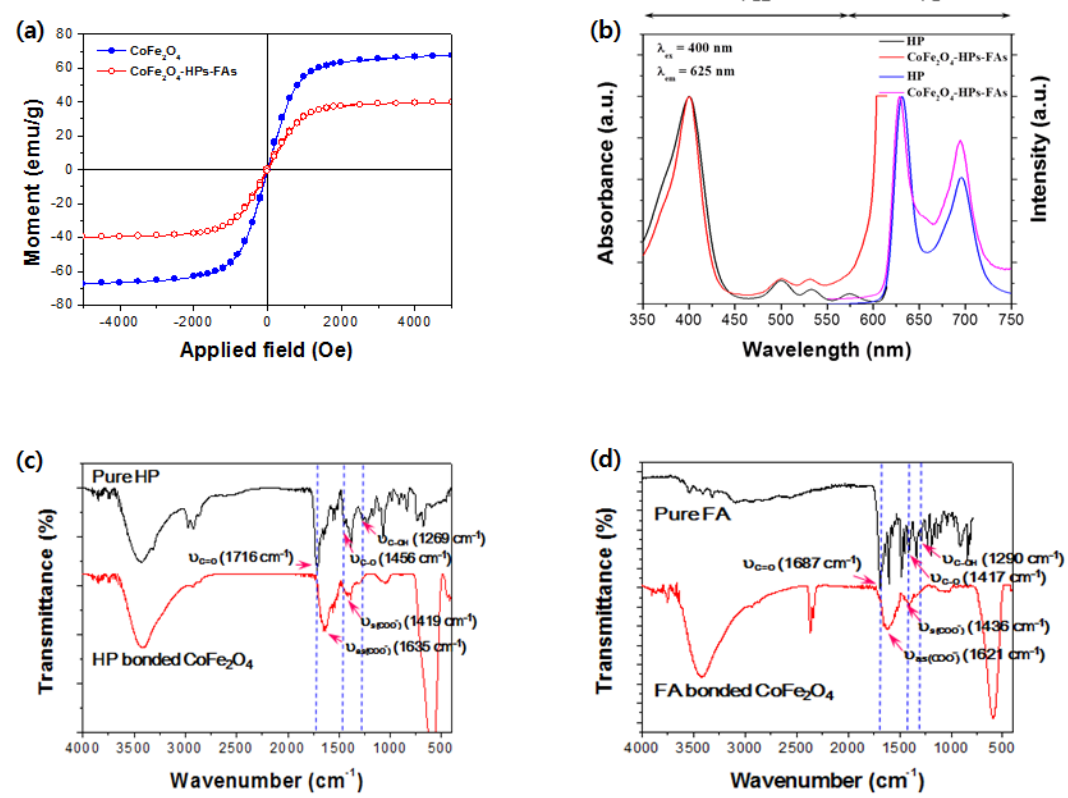
Figure 2. Photophysical and magnetic properties of multifunctional magnetic nanoparticles. ( a ) Room-temperature magnetic hysteresis loops of the CoFe 2 O 4 nanoparticles and the CoFe 2 O 4 -HPs-FAs; ( b ) photoluminescence and photoluminescence excitation spectra of pure HP and CoFe 2 O 4 -HPs-FAs in THF; FT-IR spectra of ( c ) pure HP and HP bound with CoFe 2 O 4 and of ( d ) pure FA and FA bonded with CoFe 2 O 4 .